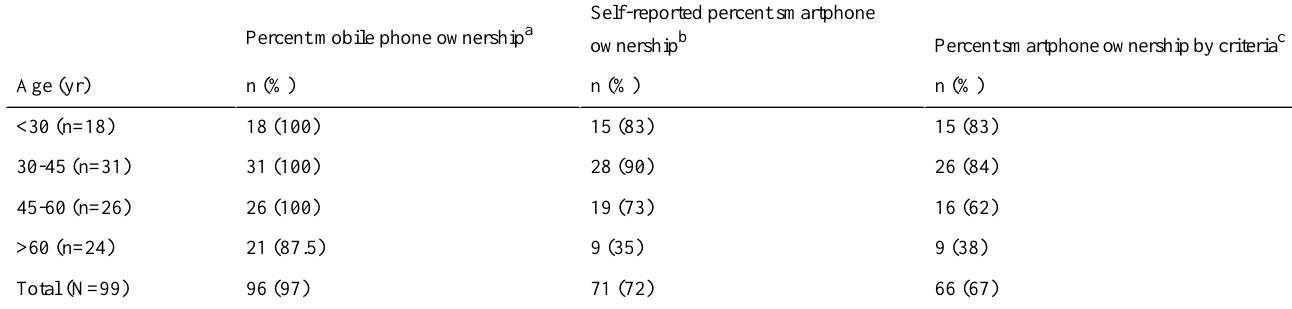
Table 2. Mobile phone and smartphone ownership (N=99).